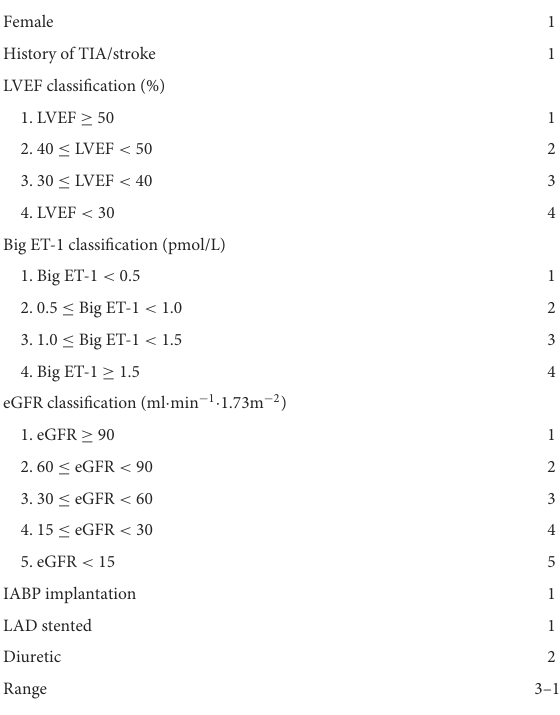
TABLE 3 Risk score